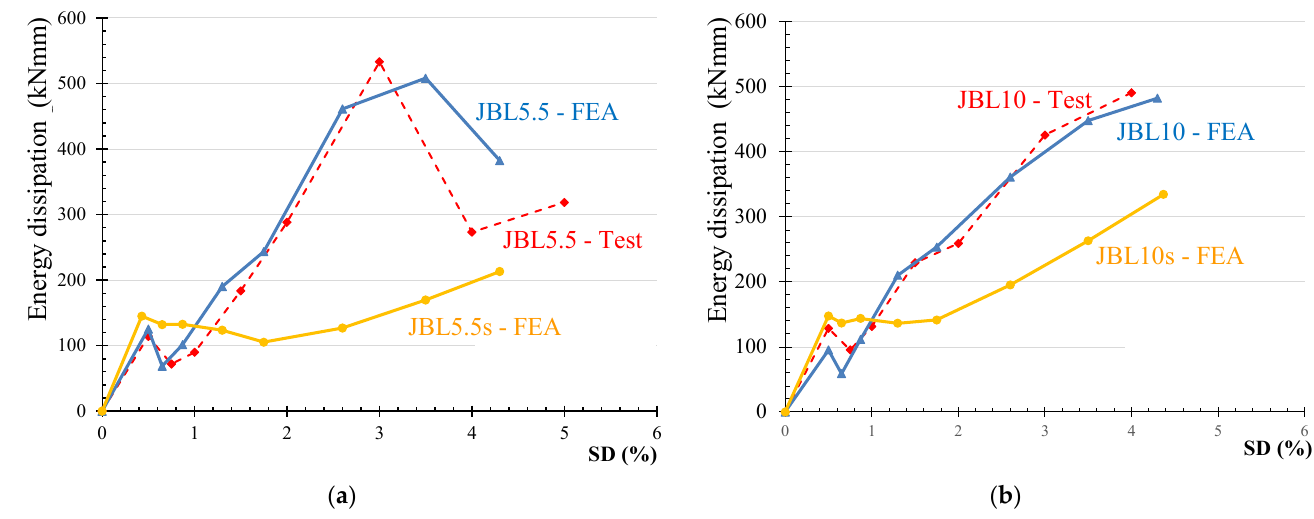
Figure 14. Energy dissipation versus SD diagrams, comparison and verification of results: ( a ) JBL5.5—Test, JBL5.5—FEA, JBL5.5s—FEA and ( b ) JBL10—Test, JBL10—FEA, JBL10s—FEA.